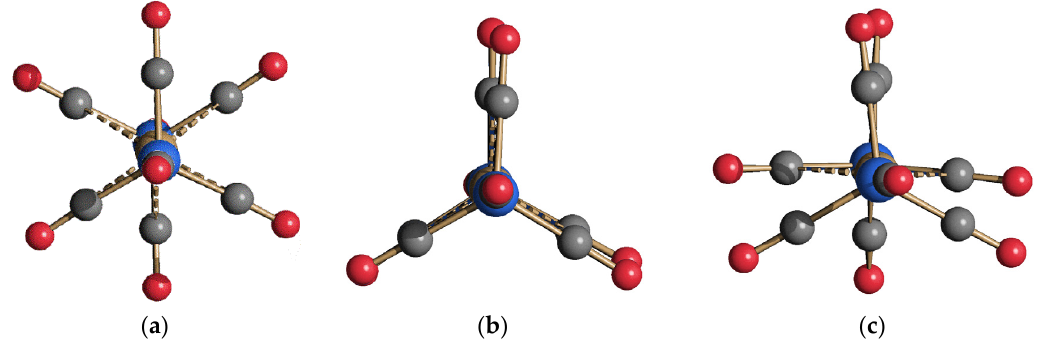
Figure 5. The three isomers of 2 : ( a ) TBP-TBP staggered; ( b ) TBP-TBP eclipsed; ( c ) TBP-Td. Sub Van der Waals M ··· C(O) contacts are represented as fragmented lines (brown, Cu; blue, Co; red, O; grey, C) [39–41].